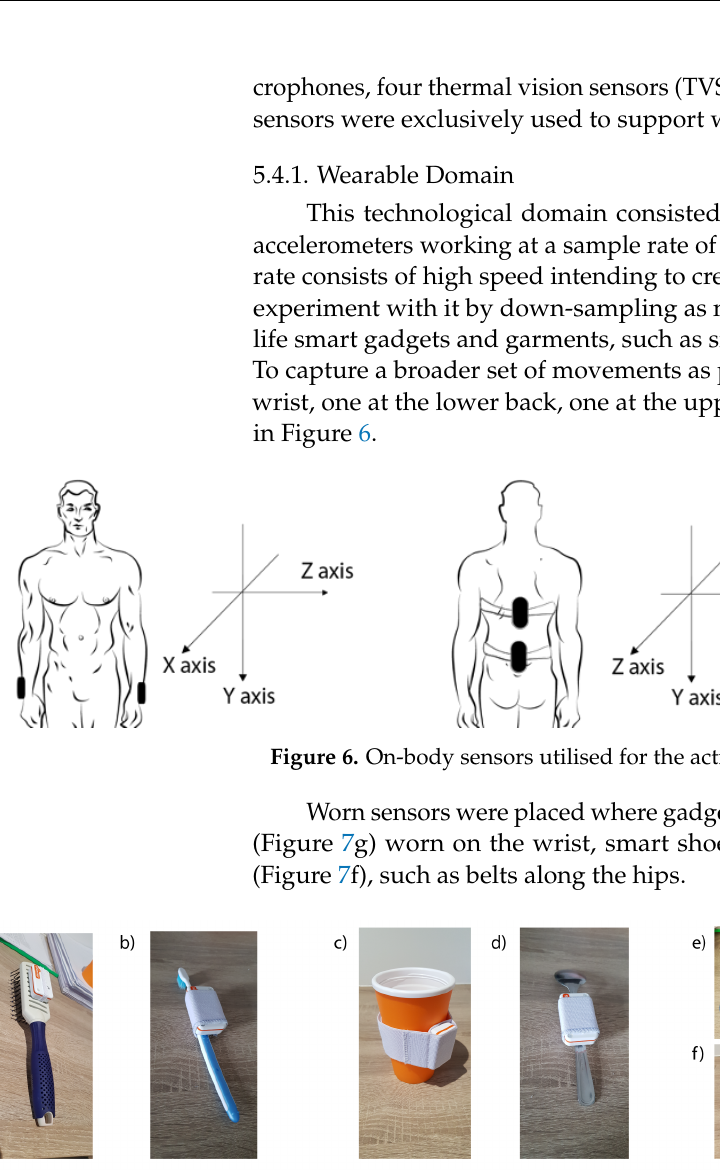
Figure 7. Sensor devices mounted on daily-life items. They are attached relying on the pressure force of elastic material from homemade straps. Items consisted of ( a ) comb, ( b ) toothbrush, ( c ) glass, ( d ) spoon, ( e ) joggers, ( f ) belt, ( g ) strap to mimic a watch, and ( h ) strap to mimic smart